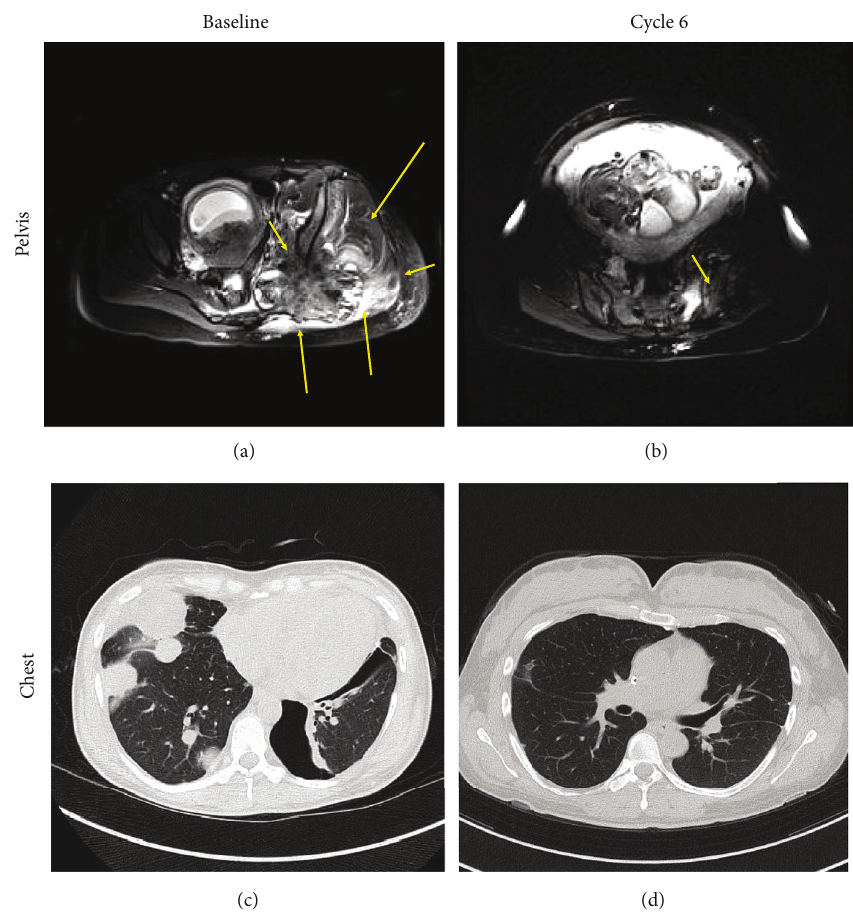
Figure 2: Computed tomography scans of (a, b) pelvis and (c, d) chest for case 3. CT scan was performed at baseline prior to starting treatment (a, c) and again after 6 cycles and 4.5 months of therapy (b, d). Resolution of lung metastases and pneumothorax is